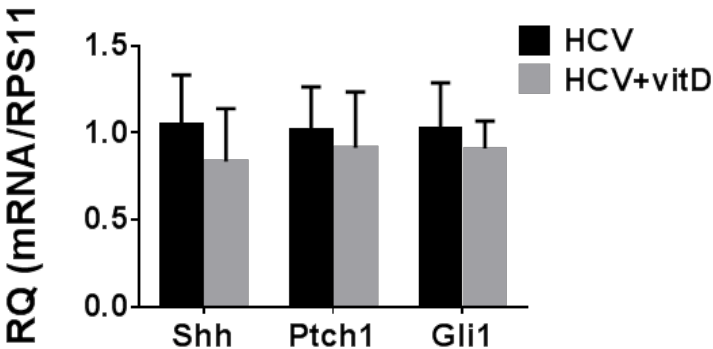
Figure 4. E ff ect of vitamin D 3 on mRNA levels of Hedgehog (Hh) pathway target genes in VDR-KO Huh7.5 cells. VDR-KO Huh7.5 cells were treated with vitamin D 3 (5 µ M) three hours prior to infection. Hh target genes expression levels were determined by real-time PCR analysis. Results are presented as relative quantity of target gene mRNA normalized to RPS11 mRNA values. HCV-infected cells were assigned a value of 1. Results are shown as means RQ ± SD of three experiments.